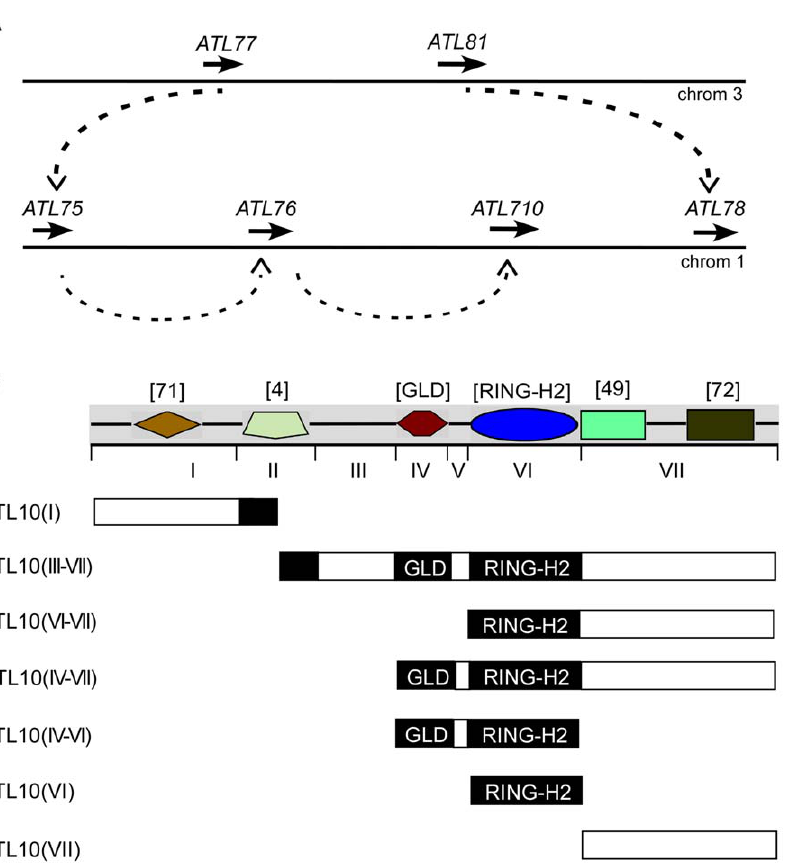
Figure 7. Inferred evolutionary history and organization of ATL10 . (A) The inferred evolutionary history of ATL10 is depicted. A segmental duplication event involving chromosomes 1 and 3 generated ATL78 and ATL75 , from ATL81 and ATL77 , respectively; ATL10 was then generated by tandem duplication events from ATL75 . (B) The upper diagram depicts the modular organization of ATL10 based on sequence LOGOs mapped to it. Below is the schematic representation of seven clones encompassing different regions of ATL10 that were used in yeast two-hybrid assays.